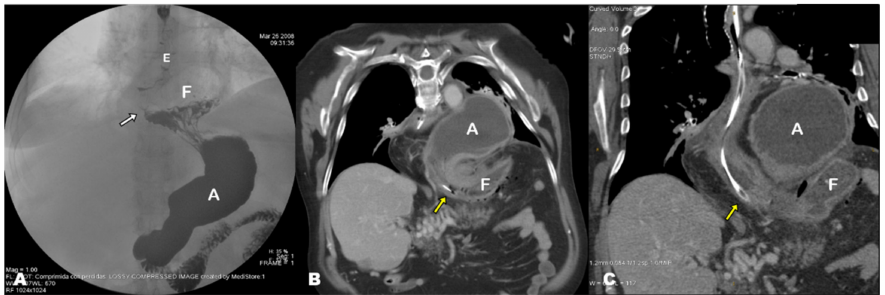
Figure 3. ( A ) Barium swallow performed 10 years prior to acute presentation, anteroposterior view. The gastroesophageal junction (white arrow) along with part of the gastric fundus (F) are located above the diaphragm. These are typical findings of sliding hiatal hernia. ( B , C ) Contrast-enhanced abdominal CT image at the acute presentation, coronal-oblique MPR view. Acute gastric volvulus showing the antrum (A) and fundus (F) above and below the diaphragm, respectively. Note the nasogastric tube (yellow arrows) at the level of the diaphragm. E,